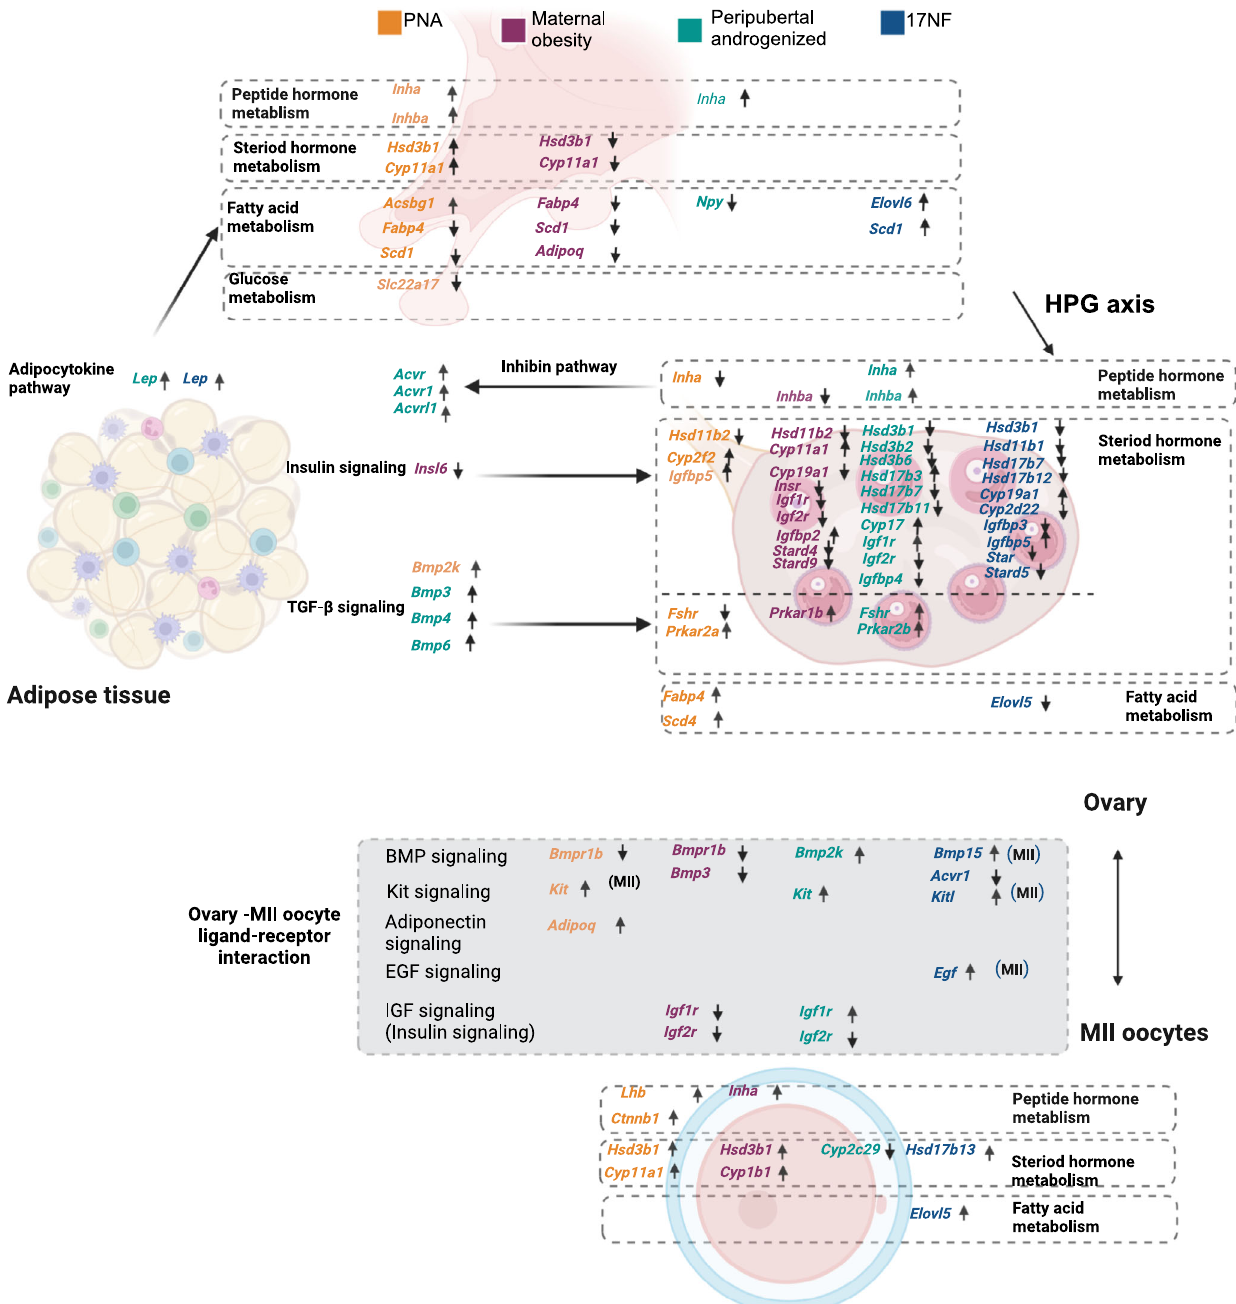
Fig. 7 Transcriptomic interaction among hypothalamus, ovary, adipose tissue, and MII oocytes in PCOS-like models. a Transcriptomic crosstalk and unique gene signatures among hypothalamus, ovary, adipose tissue, and MII oocytes in PNA, maternal obesity, Peripubertal androgenized, and 17NF,